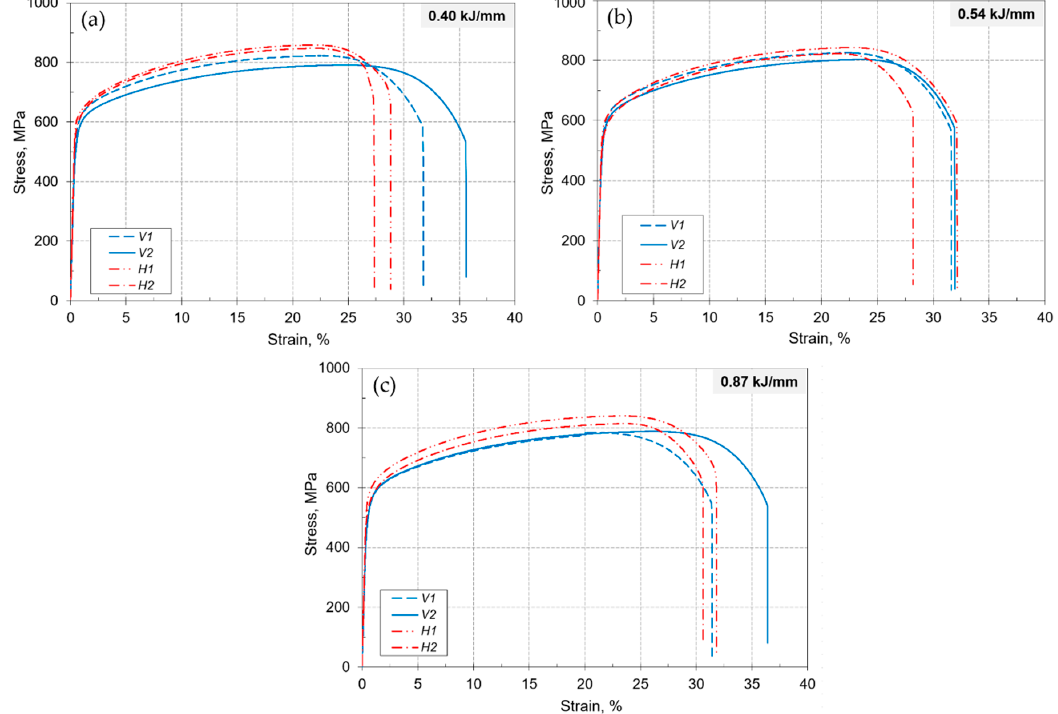
Figure 4. Stress strain curves of samples with heat inputs of ( a ) 0.40 kJ/mm, ( b ) 0.54 kJ/mm and ( c ) 0.87 kJ/mm. H1 / H2 are horizontal and V1 / V2 are vertical samples.